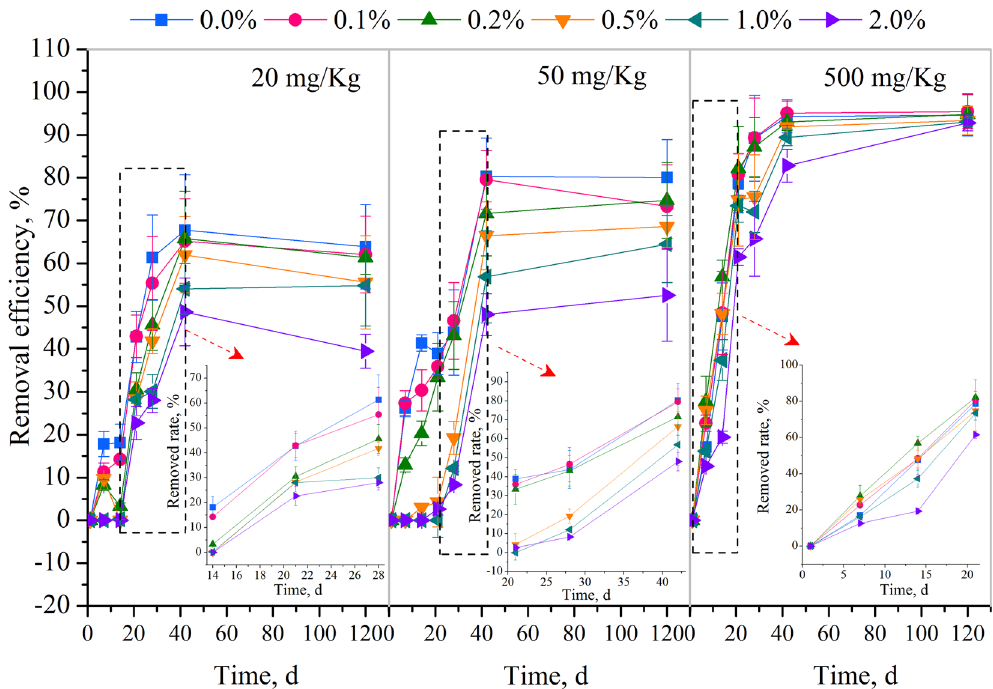
Figure 1. NP biodegradation curves in RC-sediment system with different RC percentages. NP rapid biodegradation period were marked with a dotted frame and showed in an enlarged figure for each NP